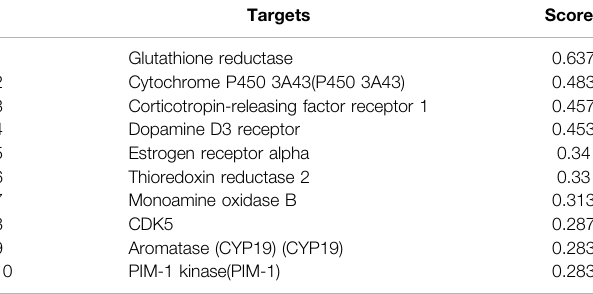
TABLE 1 | The ten most likely targets of hypericin predicted by the TarPred platform. Higher scores indicate a higher likelihood.